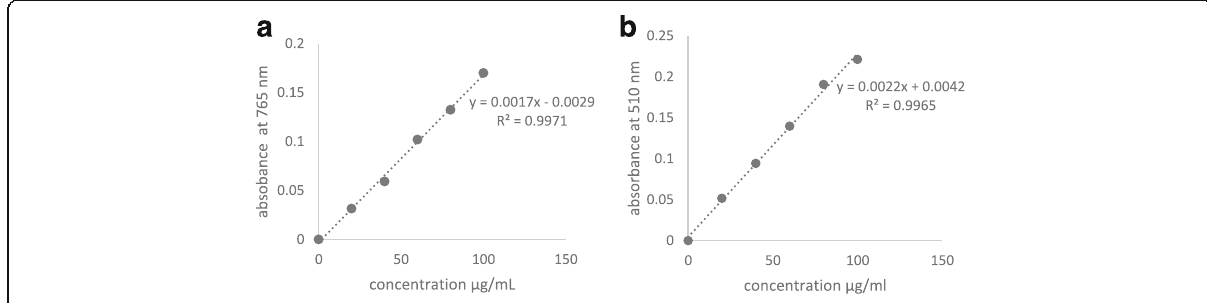
Fig. 1 Standard curves of ( a ) Gallic acid and ( b ) Quercetin shows the absorbance against concentration